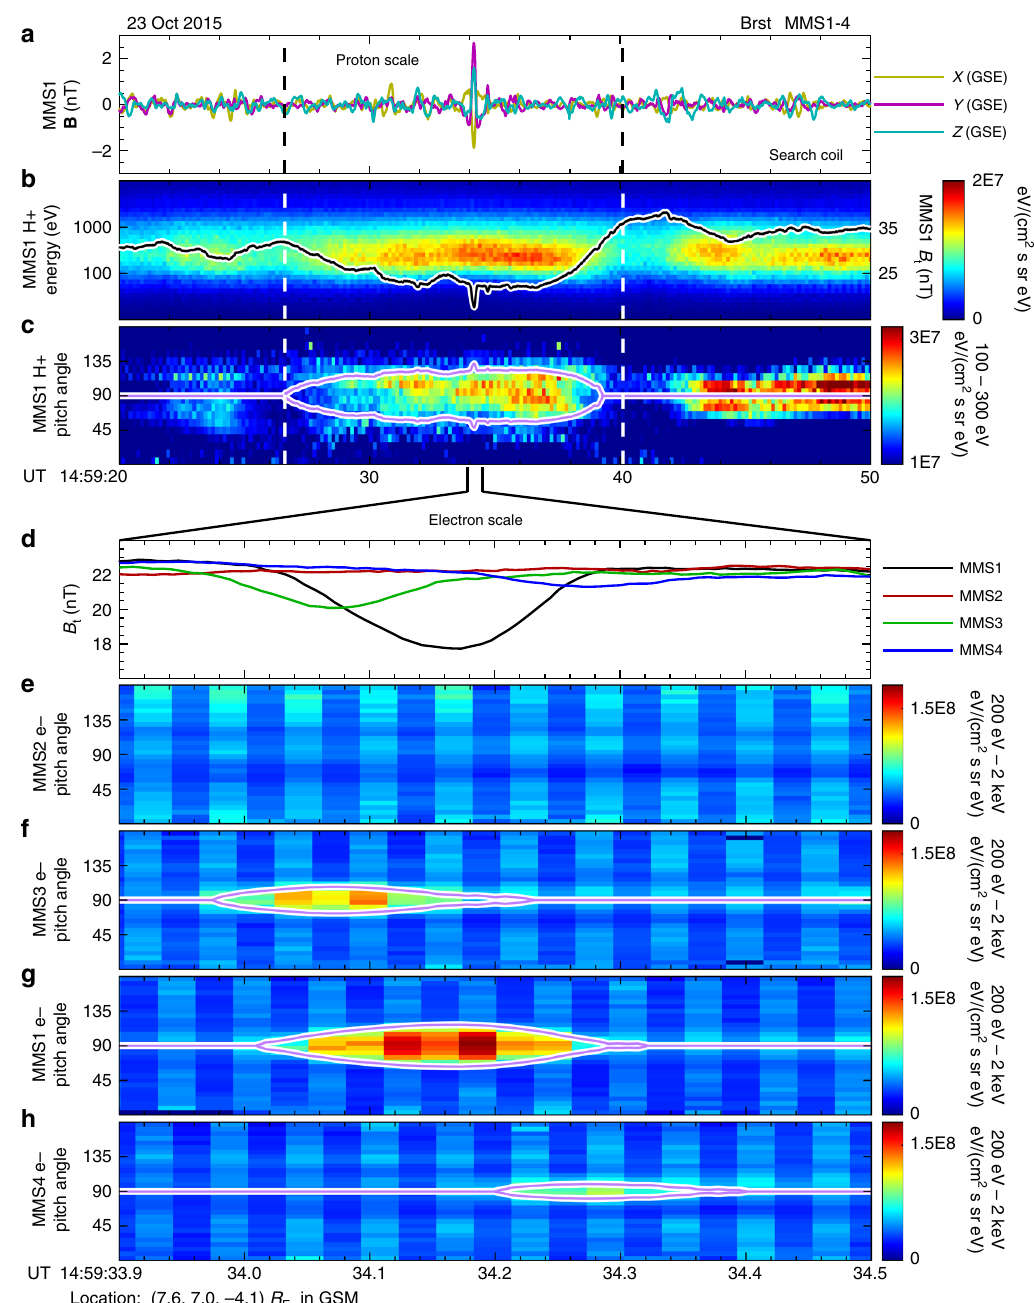
Fig. 1 MMS observations of an ESMC coupled with a proton scale magnetic cavity. Panels a – c show MMS1 observations of turbulent magnetic fi elds, proton energy – time spectrogram as well as the total magnetic fi eld ( B t ), and proton pitch angle distribution (PAD) in 30 s from 14:59:20UT to 14:59:50 UT on 23 October 2015. A depression region of B t is marked with two dashed vertical lines across the four panels. The B t observed by MMS1 is over-plotted as a black curve in panel b . The magenta curves in panel c represent a local loss cone, derived from the variation of B t . The ESMC discussed in this paper is the fi rst one of two sudden dips of B – h , with a very short time scale (0.6 s). t near 14:59:34 UT in panel b , the observations of which are detailed in panels d Panel d shows B t observed by four MMS spacecraft, and panels e – h show electron PADs observed by MMS2, 3, 1, and 4, respectively. In panels f – h the corresponding local loss cones are over-plotted as magenta curves. Spacecraft positions are labeled at the bottom of the fi outside the depression region. The region enclosed by magenta We found that the PSMC is coupled with a much smaller curves in panel c is an expected trapping region by the magnetic (electron scale) magnetic structure. There are two prominent mirror force, which agrees well with observations of the proton sudden dips of B t near 14:59:34 UT in panel b. It is illustrated energy fl ux enhancement. The simultaneous magnetic fi eld below that the fi rst dip is also a magnetic cavity, which is depression and enhancement in the proton energy fl ux indicate embedded inside the proton scale structure. Panels d – h show the existence of a proton scale magnetic cavity (PSMC) between observations of the electron scale structure during a very short the two dashed lines. time scale (0.6 s). The B t of MMS2 remains unchanged during